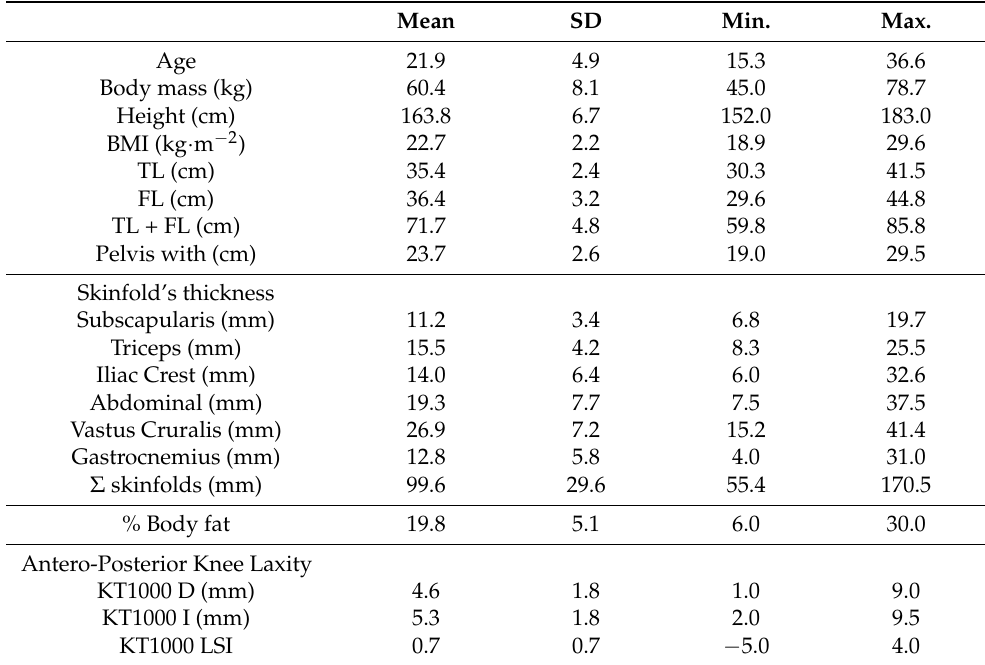
Table 1. Anthropometric characteristics and AP knee.